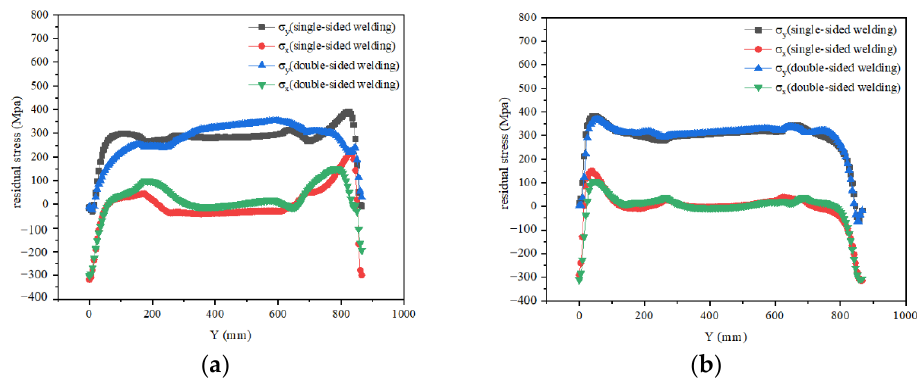
Figure 24. Residual stress distribution in the y direction. ( a ) Path1; ( b ) Path2.